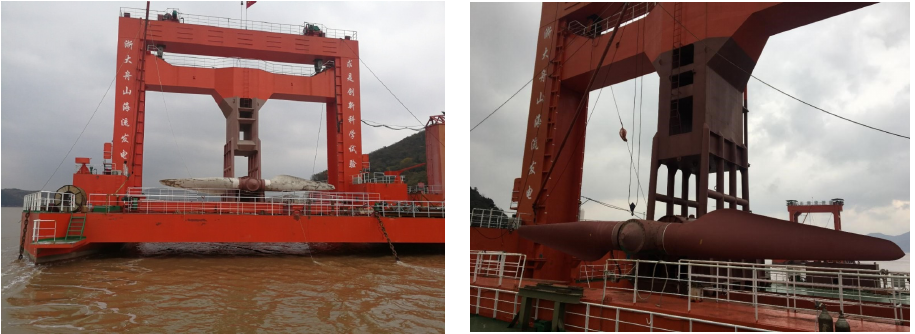
Figure 22. Prototype launched in 2017 ( left ) and optimized prototype in 2020 ( right ). Reproduced from [62].